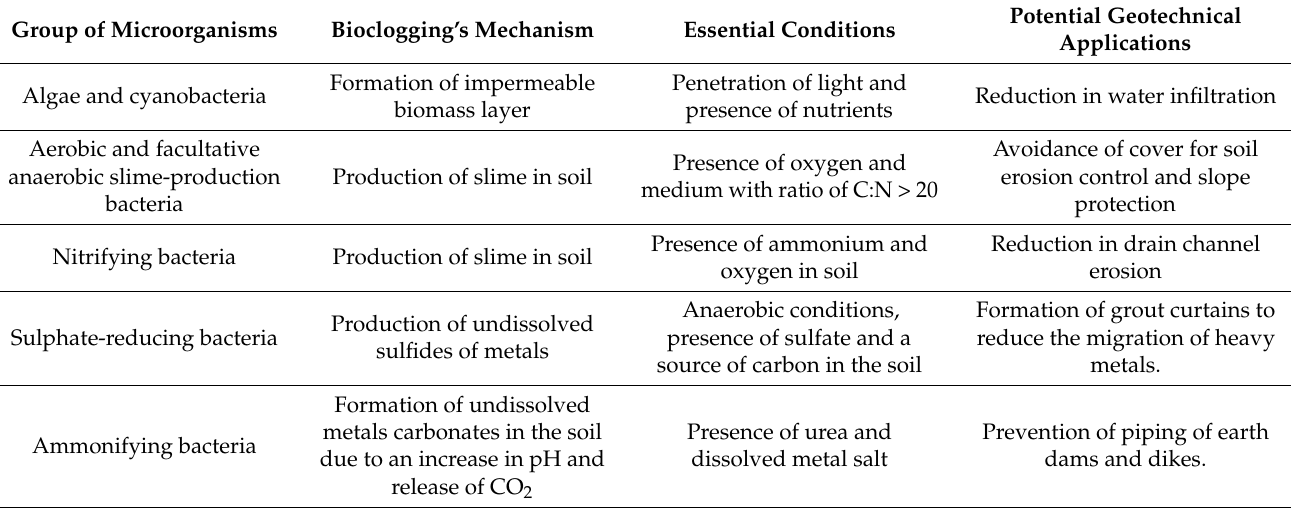
Table 2. Potential applications of bioclogging in Geotechnical Engineering (based on Ivanov et al. [2]). Group of